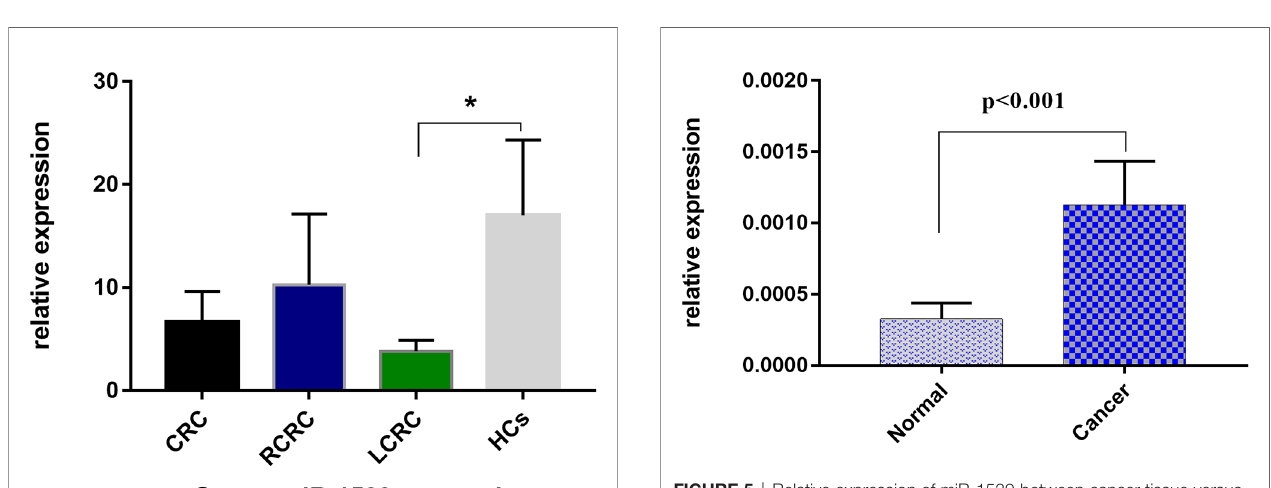
FIGURE 5 | Relative expression of miR-1539 between cancer tissue versus matched normal tissue. miR-1539 was overexpression in cancer tissue. Y-axis represents miR-1539 relative expression by 2 - △ Ct method. Mean with 95%CI are performed in the